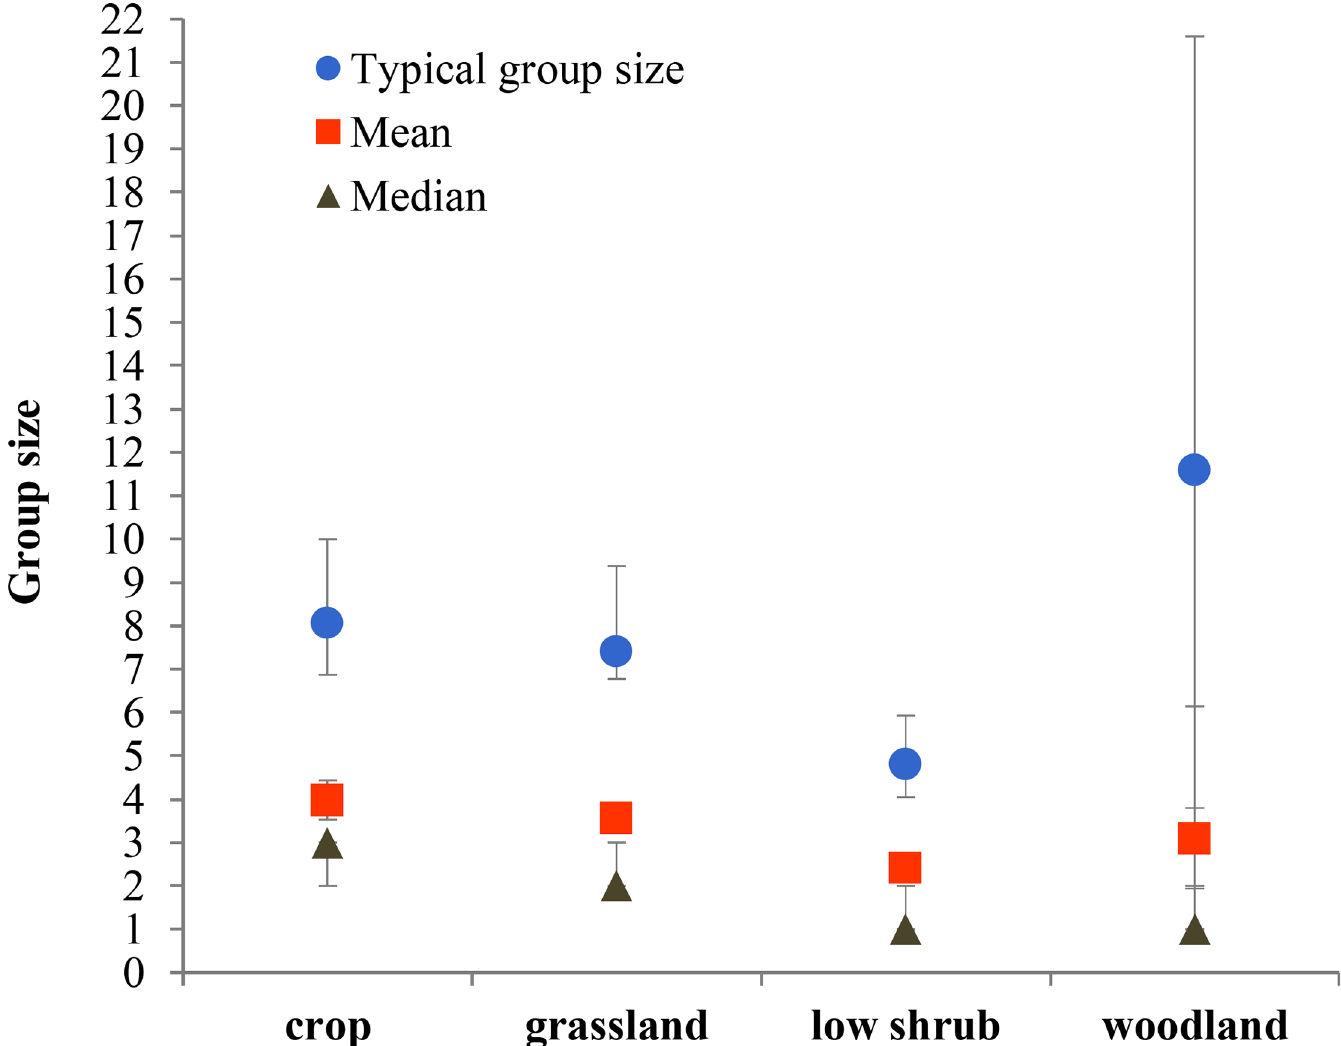
Fig 4. Typical, mean and median group sizes according to habitat. In typical and mean group sizes bars are 95% confidence intervals (CIs); in median group size CIs range between 95% and 96.2%. See S1 Table for detail